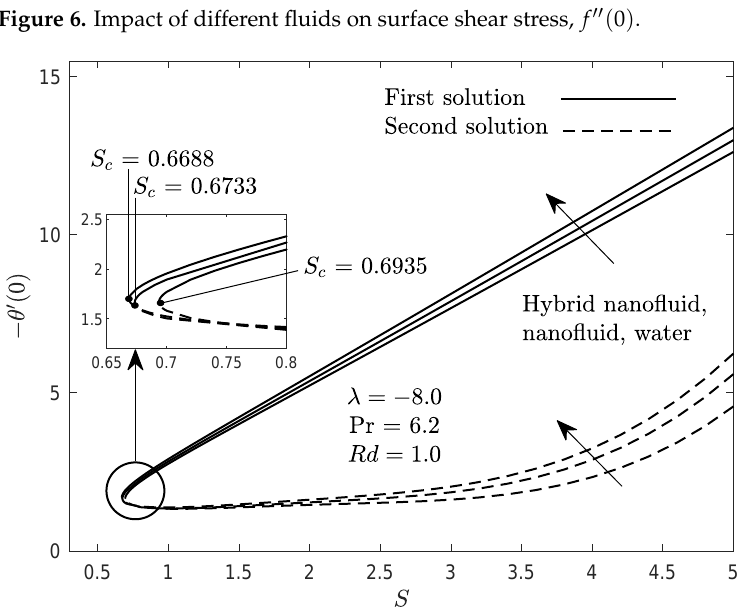
Figure 7. Impact of different fluids on local heat flux, − θ (cid:48) ( 0 )